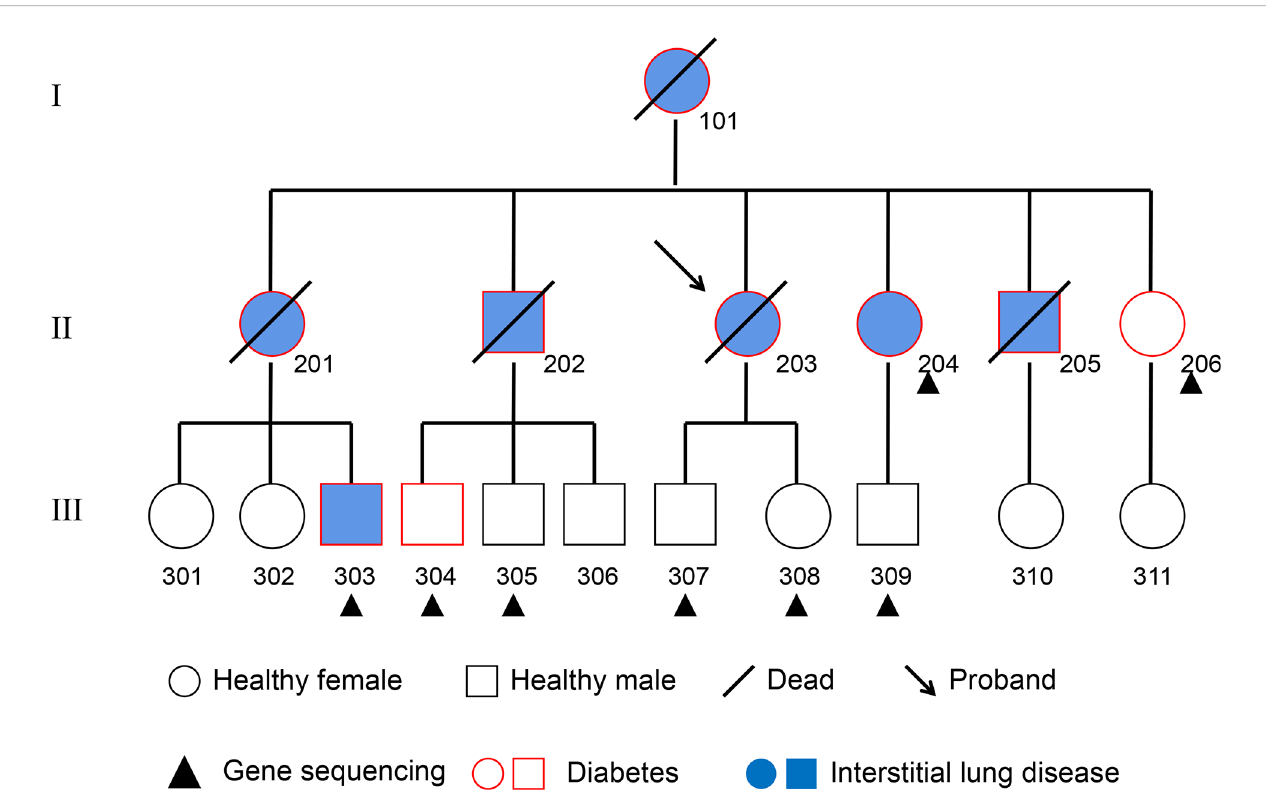
FIGURE 1 Pedigree Chart. The 8 subjects from the second and third generation who received whole-genome re-sequencing are marked with a black triangle. Squares represent males, circles represent females. The subjects affected by pulmonary fi brosis are painted blue, and the subjects affected by T2DM are indicated with a red border. Deceased individuals are labeled with a black